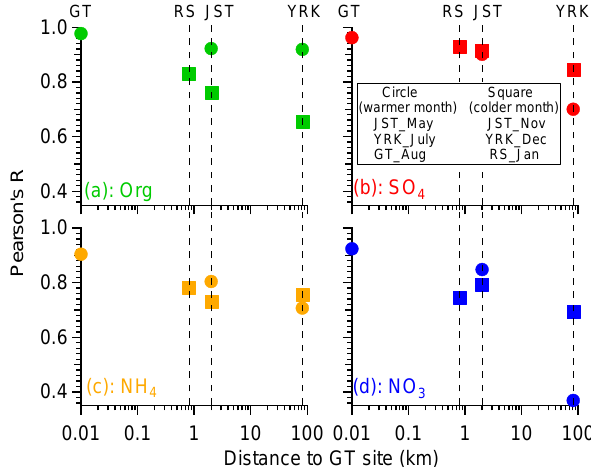
Figure 13. Correlation coefficients for NR-PM 1 species between ACSM measurements (stationary at the GT site) and HR-ToF-AMS measurements (rotating among different sites). Values are plotted vs. the relevant distance of the measurement site from the GT site. The dotted lines represent the sampling sites where the HR-ToF- AMS measurements were